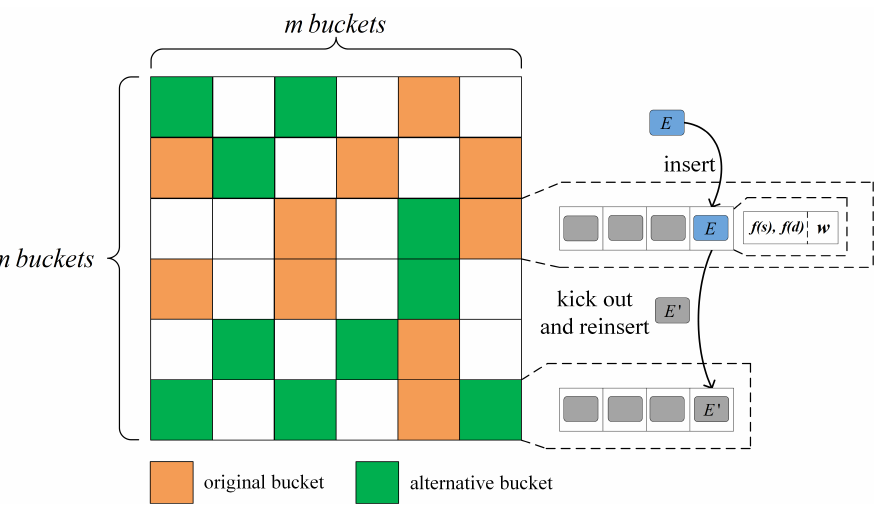
Figure 2. Architecture of Cuckoo